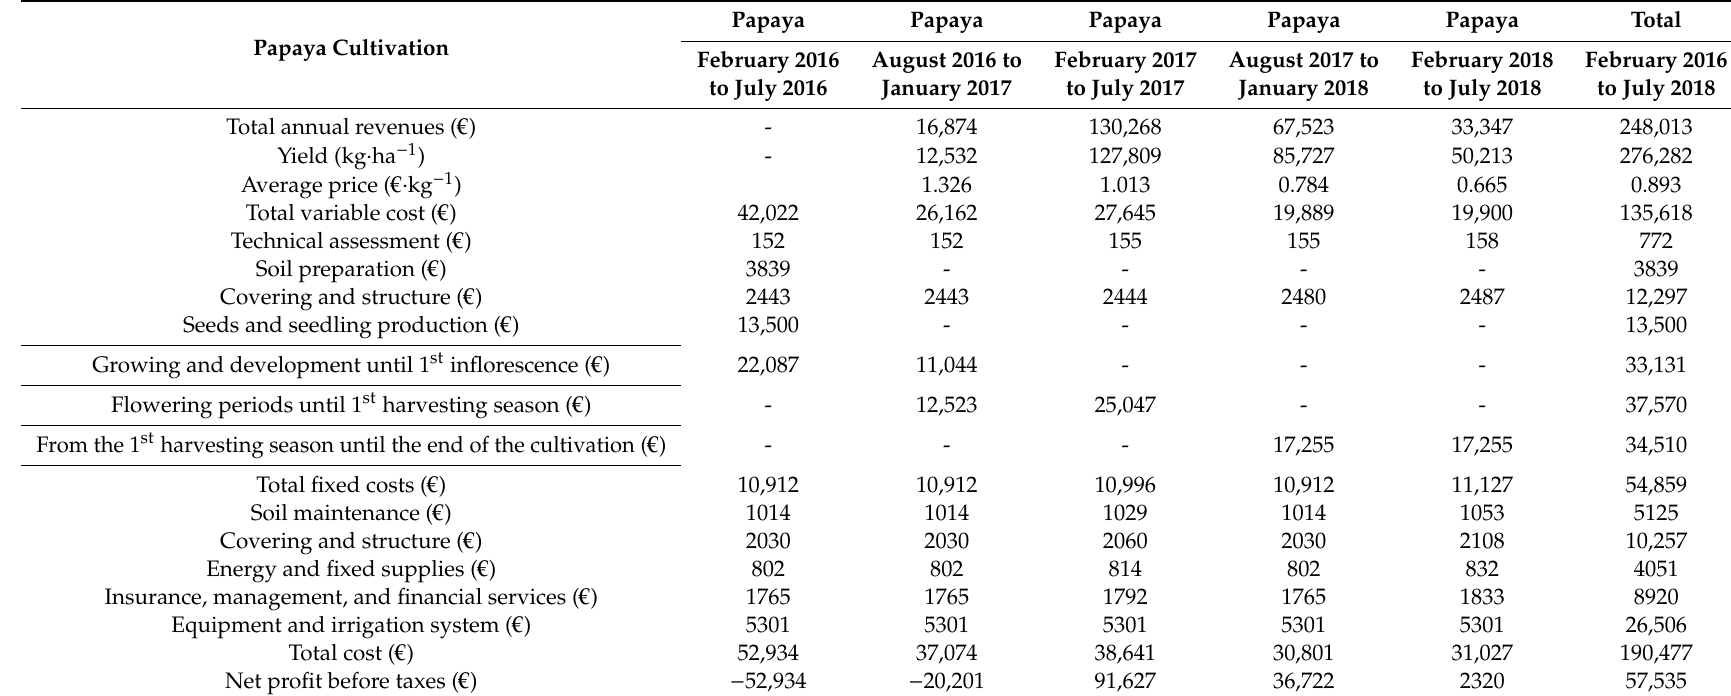
Table A2. Revenues and expenses per hectare imputed to the papaya cultivation in a 30-month cycle